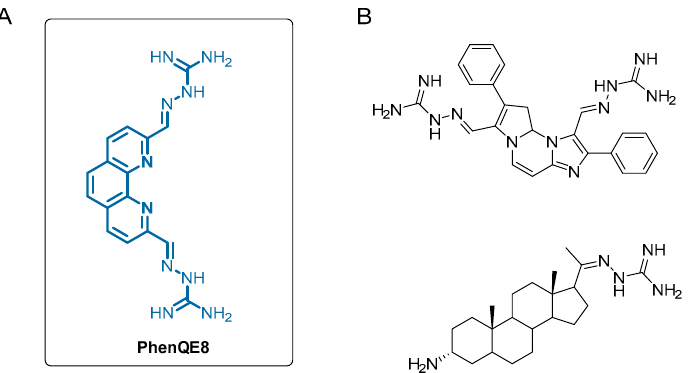
Figure 1. ( A ) Chemical structure of novel G4 ligand PhenQE8; ( B ) Examples of other quadruplex ligands containing the guanyl hydrazone group [47,48].